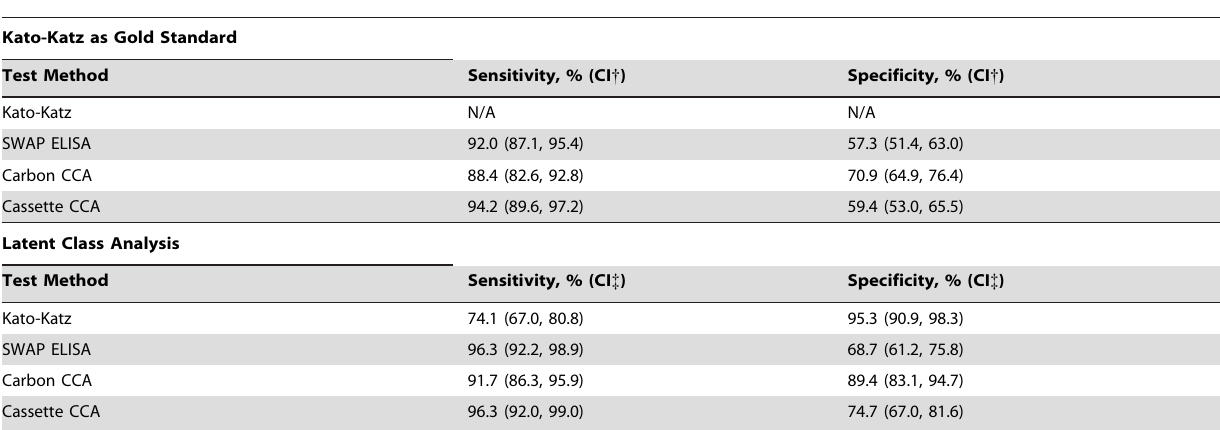
Table 2. Sensitivity and specificities of tests in comparison to Kato-Katz and using LCA.